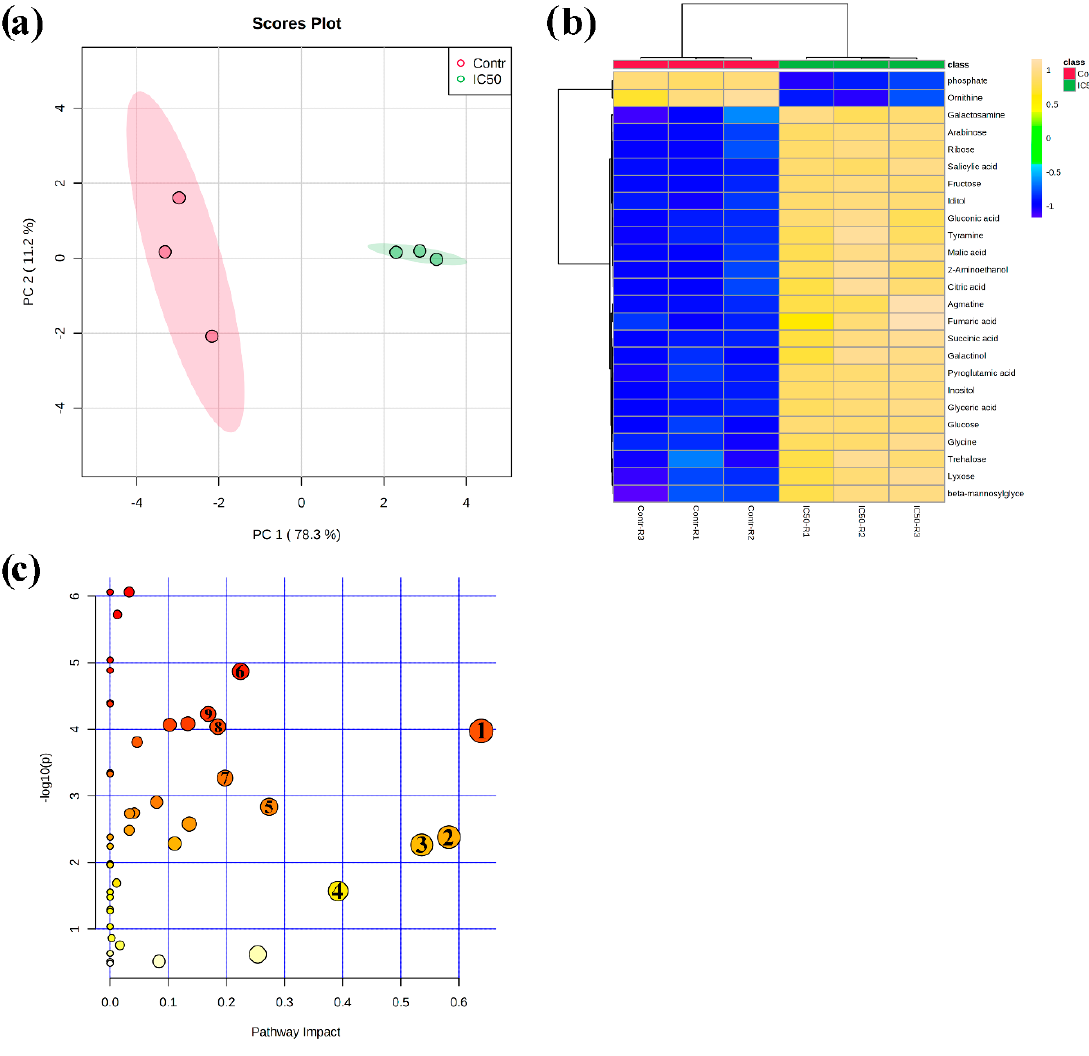
Figure 4. ( a ) Principal component analysis (PCA) score plot for control plants (red dots) and plants treated for 14 d with nerolidol 120 µ M (green dots); ( b ) overlay heat map of the top 25 metabolites profiles (selected by t -test with p ≤ 0.05) in plants treated for 14 d with nerolidol 120 µ M (IC 50 -R1–IC 50 -R3, replicates of the treated samples) in comparison with control plants (Contr-R1–Contr-R3, replicates of the controls). Each square represents the e ff ect of the treatment on the relative abundance of every metabolite using a false-color scale. Colors yellow and blue indicate relative metabolite abundances, increased and decreased, respectively; ( c ) metabolomic pathway analysis showing the p -values from the pathway enrichment analysis and pathway impact values from the pathway topology analysis, numbered circles represent the pathways most-a ff ected by the treatment (data used to build up the pathways graph are reported in Table 2). Full data are reported in Table S1 (raw data and PCA) and Table S3 (pathway analysis) ( n = 3).